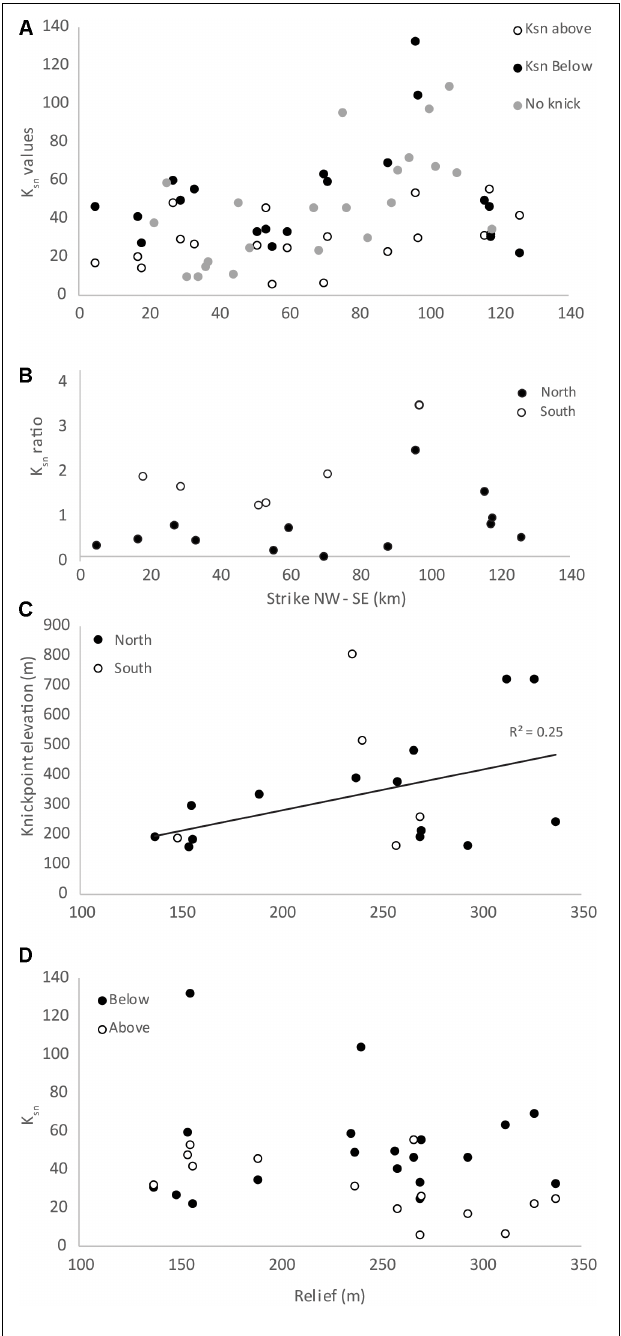
FIGURE 13 | (A) K sn against distance along strike of Makira showing the difference in values for rivers above and below the knickpoints (where present) and k sn for the whole river (where knickpoints are absent). (B) K sn ratio (below knickpoint/above knickpoint) of rivers along the island of Makira. Figure 8 . (C) Knickpoint elevation and (D) K sn against topographic relief for Makira.